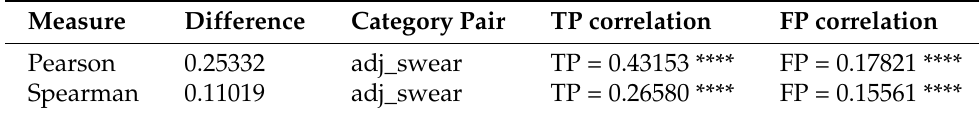
Table 40. Adjectives and Swearing in Low